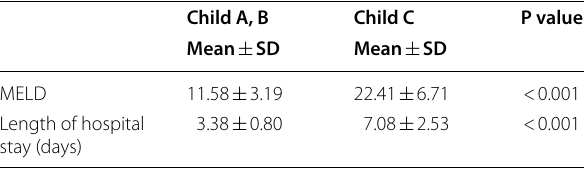
Table 3 Model for end‑stage liver disease (MELD), and length of hospital stay